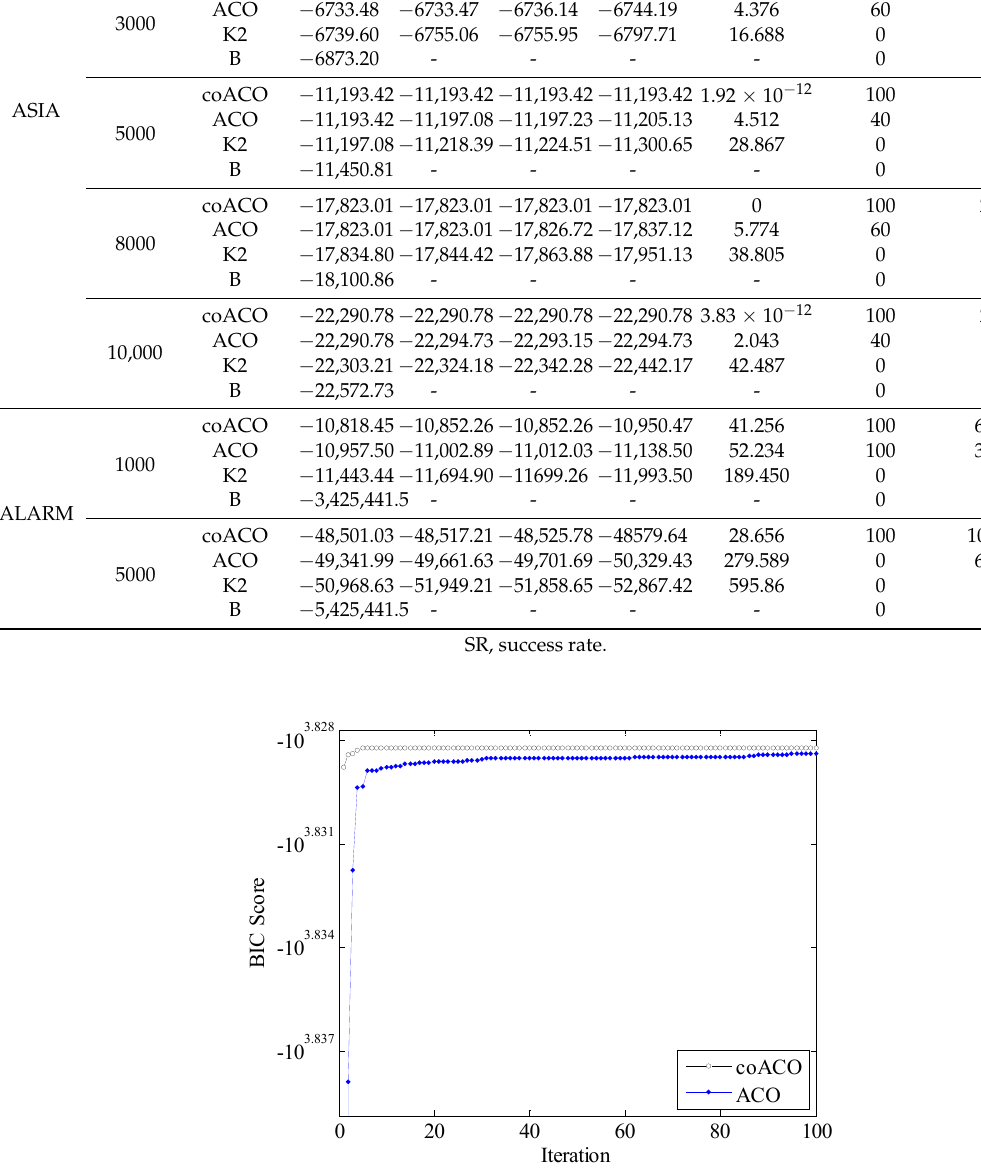
Figure 5. Evolution curves of the average BIC score achieved by ACO and coACO on the ASIA dataset with n = 3000.